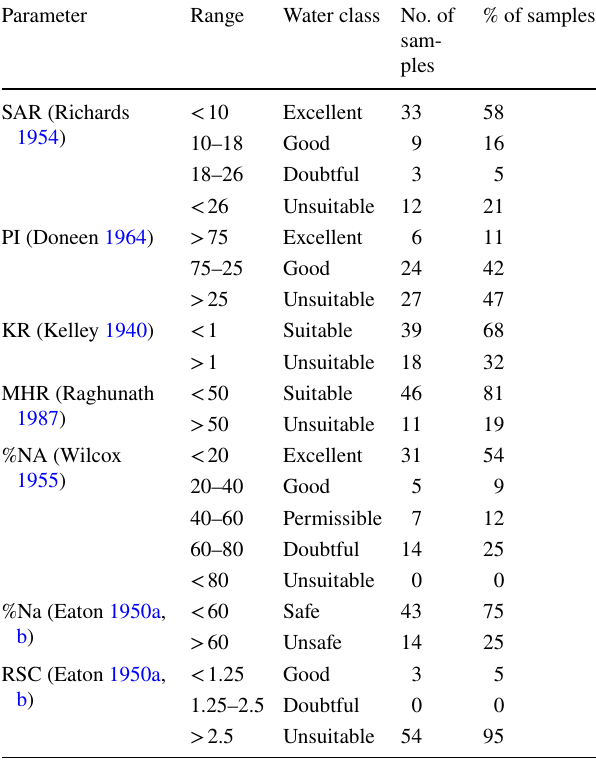
Table 5 Irrigation groundwater quality indices values